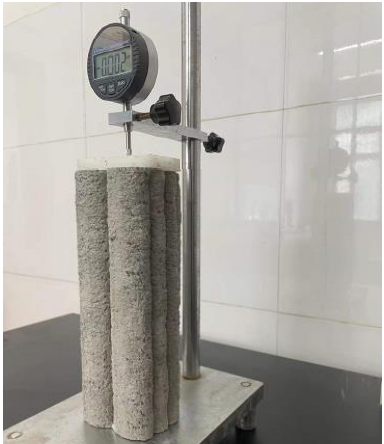
Figure 3. Measurement setup for the drying shrinkage test.